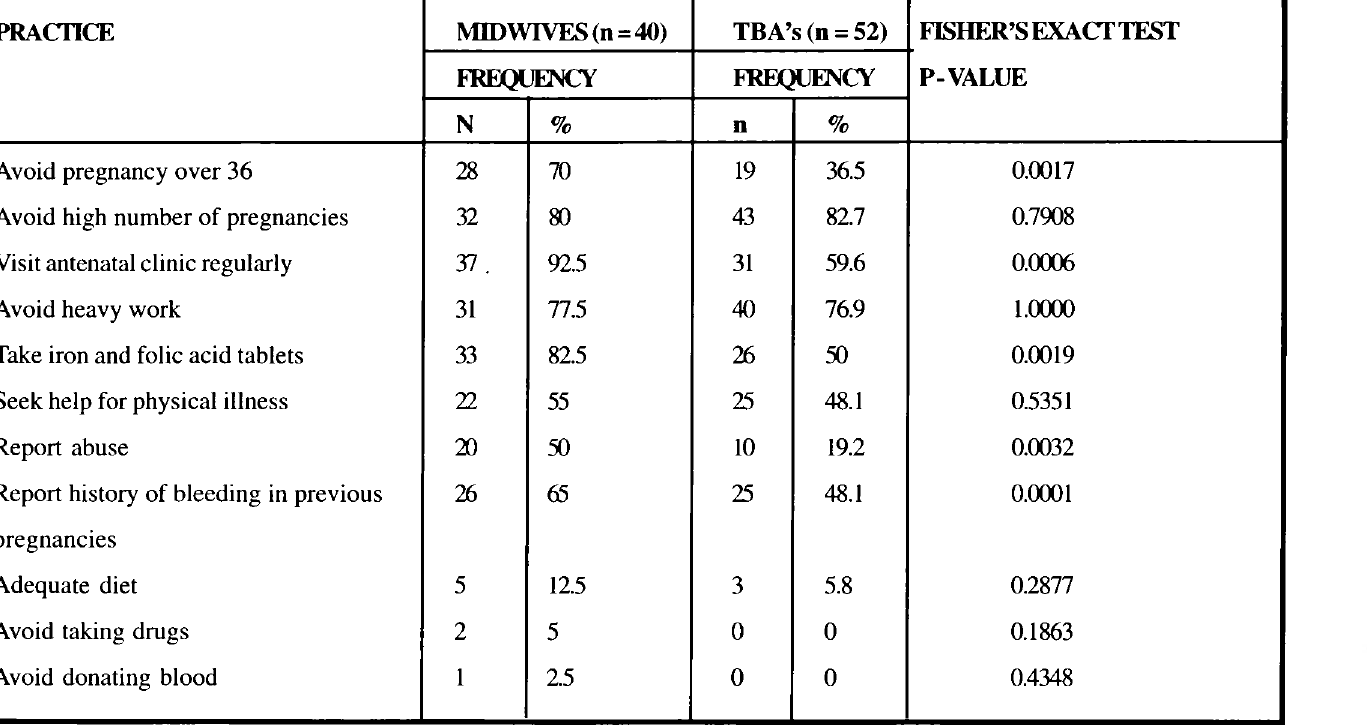
Table 1. Recommended practices for prevention of bleeding in pregnancy (APH)